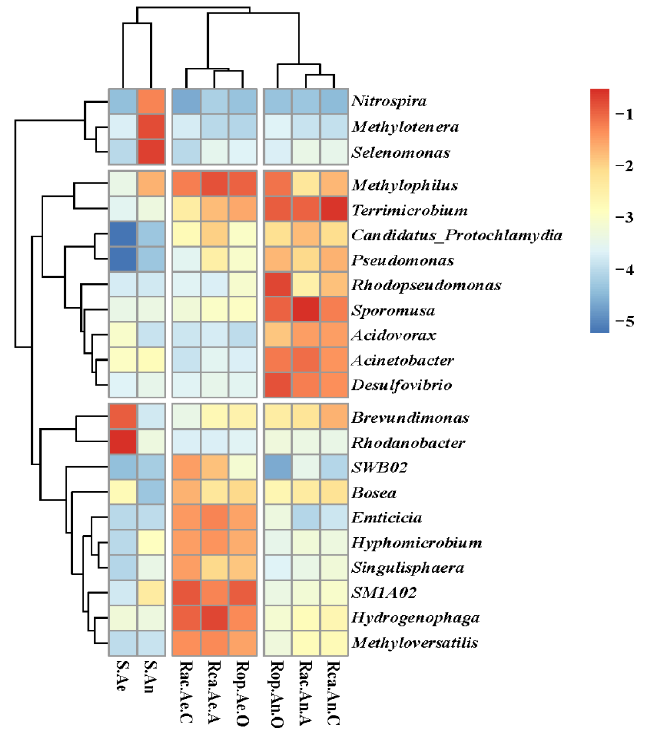
Figure 5. Heatmaps of bacterial communities of the eight samples at the genus level. S.Ae and S.An were collected from initial aerobic and anaerobic sludge; Rac.Ae.C, Rca.Ae.A, and Rop.Ae.O, were collected from the aerobic zones of Rac, Rca and Rop; Rac.An.A, Rca2.An.C, and Rop.An.O were collected from the anaerobic zones of Rac, Rca, and Rop.